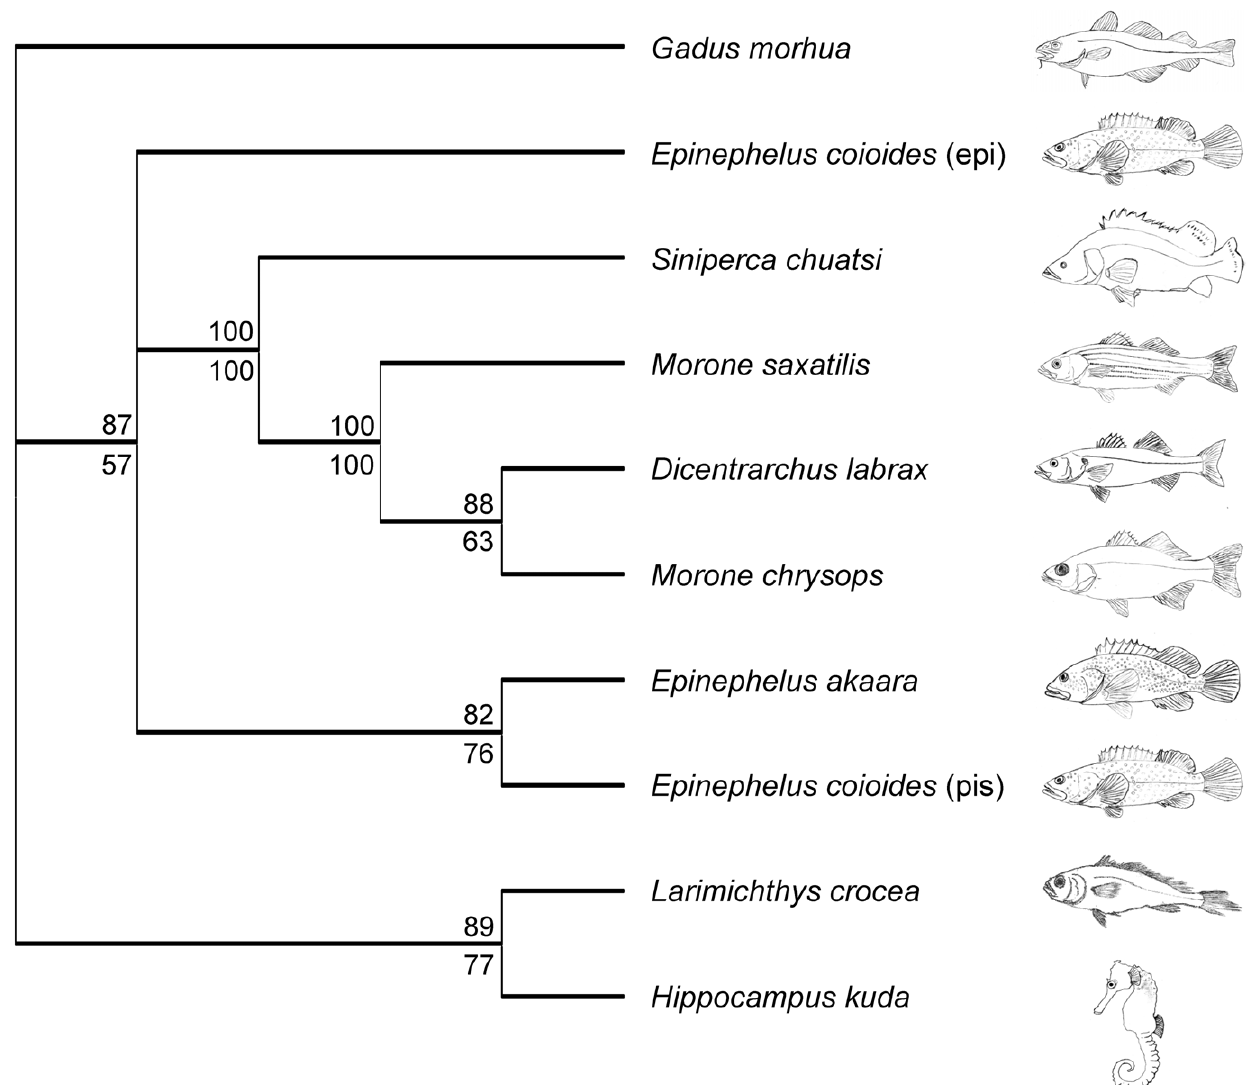
Figure 2. Unrooted rectangular cladogram illustrating the phylogenetic relationship between piscidins. The SYM + G model was selected for the Bayesian analysis and the consensus tree was built after burning 1,250 trees from the 5 ? 10 5 generations. The likelihood phylogeny was obtained with a HKY nucleotide substitution model with a discrete c distribution (4 categories, c shape parameter 2.0) and 100 bootstrap data sets. Bayesian posterior probabilities and maximum likelihood bootstrap values are indicated as percentages above and below the tree nodes, respectively.